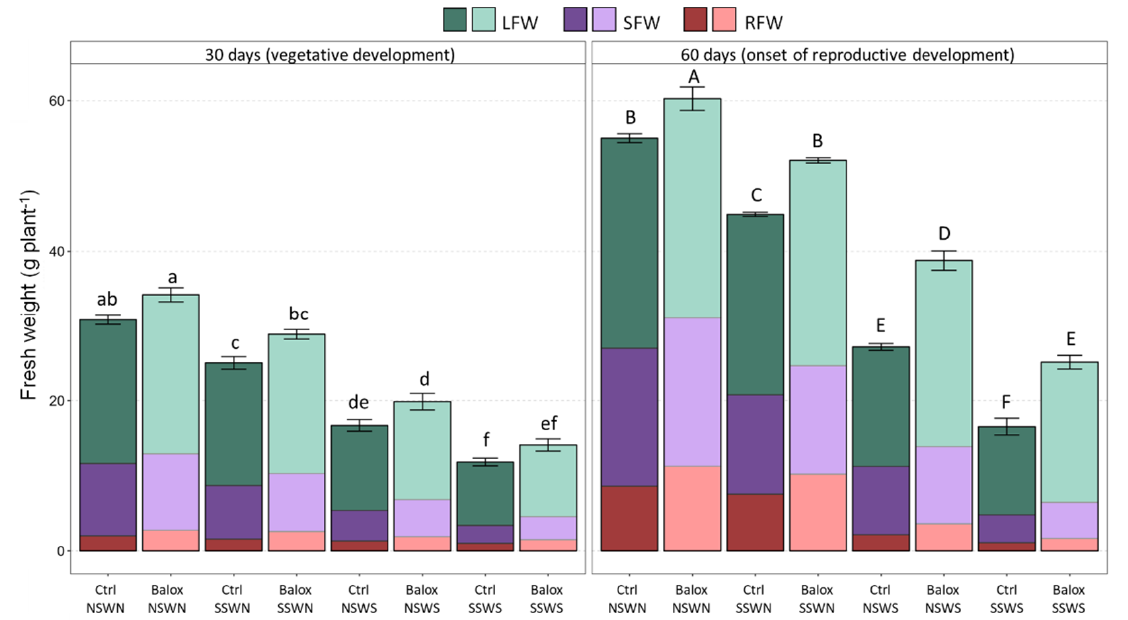
Figure 2. Total fresh weight, shown as the sum of root, stem, and leaf FW, of tomato plants subjected to increasing salinity by different combinations of saline or non-saline soil and irrigation water; the plants were treated, or not, with the biostimulant containing polyphenols at 1.4% ( w / w ) and glycine betaine at 3.0% ( w / w ) at a dose of 0.4 mL L −1 of irrigation water. Symbols: LFW, leaf fresh weight; SFW, stem fresh weight; RFW, root fresh weight. The control treatments without biostimulant (Ctrl) and with biostimulant (BALOX ® ) are defined as follows: (i) NSWN: Non-saline soil (EC = 2.28 dS/m) and non-saline water (EC = 0.91 dS/m); (ii) SSWN: Saline soil (EC = 8.55 dS/m) and non-saline water (EC = 0.91 dS/m); (iii) NSWS: Non-saline soil (EC = 2.28 dS/m) and saline water (EC = 10.50 dS/m); (iv) SSWS: Saline soil (EC = 8.55 dS/m) and saline water (EC = 10.50 dS/m). The evaluation periods: 30 days and 60 days of treatments. The values are the means ± SE ( n = 3). Different letters above the bars (lowercase for 30 days and capital for 60 days treatments) indicate significant differences between treatments, according to the ANOVA test ( p < 0.05). Statistical analyses were performed independently for the two treatment periods.